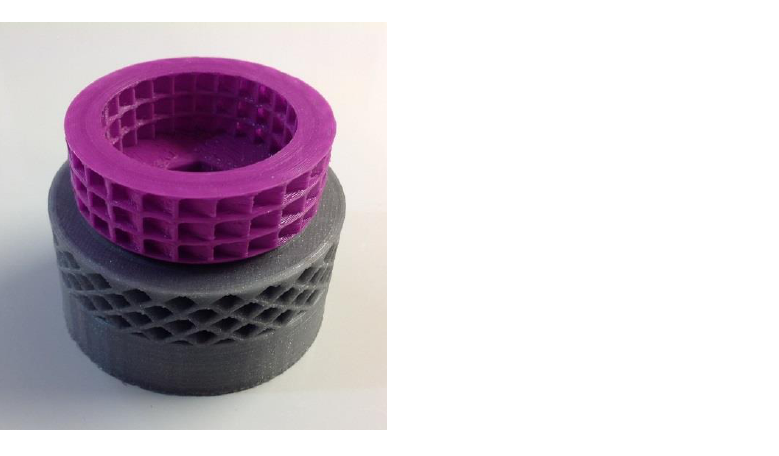
Figure 13. Micromodel of the mesh turbine rotor according to RF patent No. 203,833 (variant). Source: authors’ development.